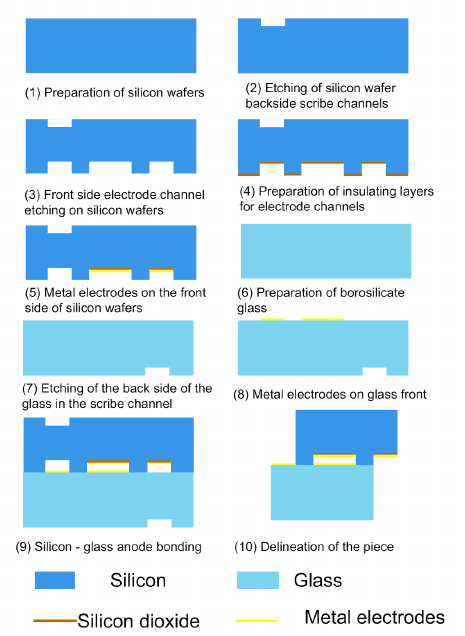
Figure 9. The schematic of each step of the sensor fabrication